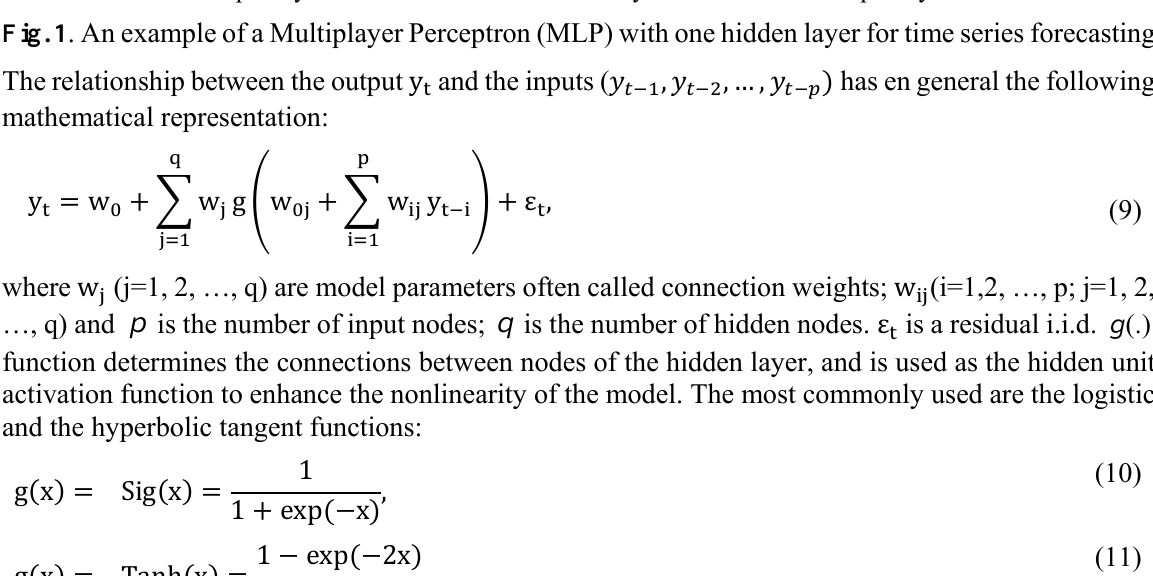
and the inputs ( (cid:1877) , (cid:1877) , … , (cid:1877) (cid:4667) has en general the (cid:2930) (cid:3047)(cid:2879)(cid:2869) (cid:3047)(cid:2879)(cid:2870) (cid:3047)(cid:2879)(cid:3043)